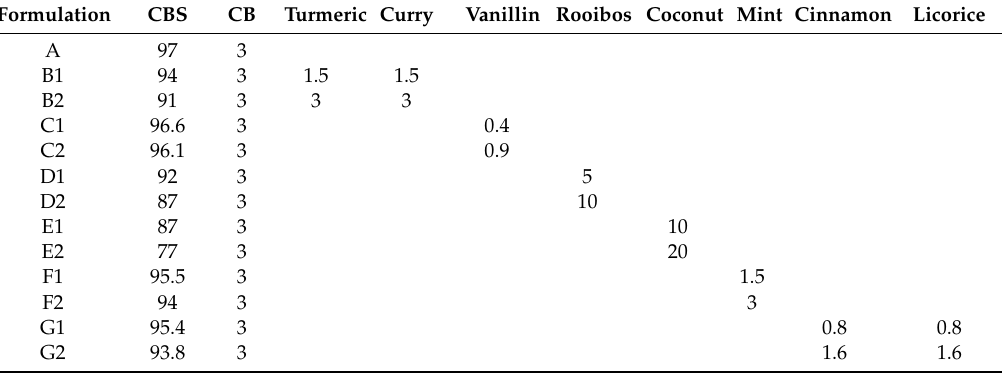
Table 1. Quantities (%) of CBS, cocoa beans (CB) and aromatic ingredients used for the production of